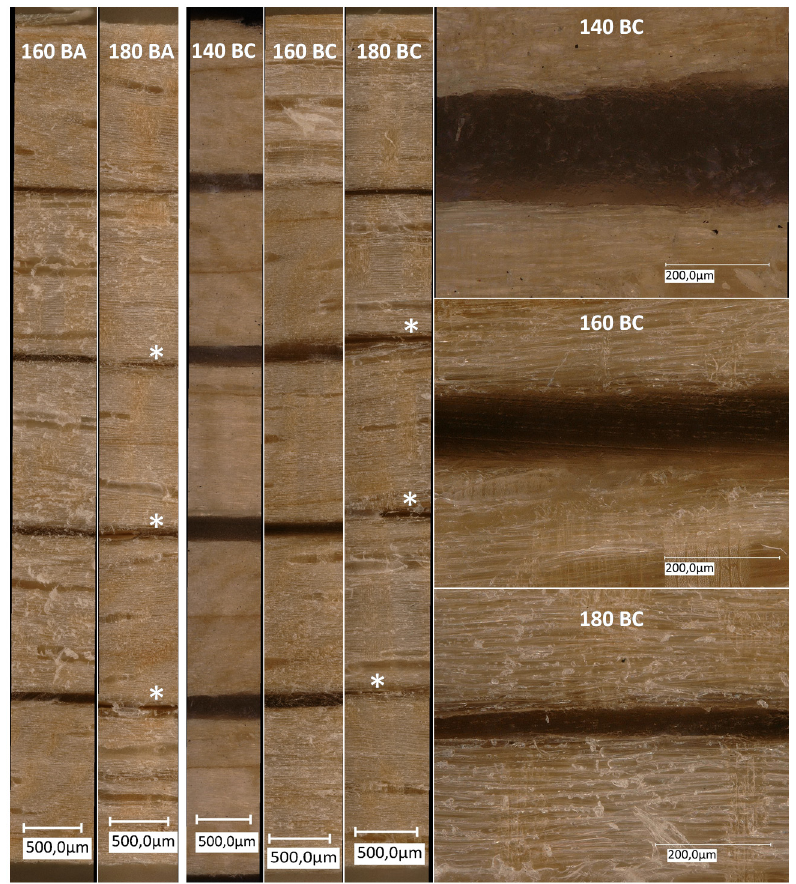
Figure 2. Comparison of birch laminated panel samples produced with amorphous (BA) and semi-crystalline (BC) PLA grades. Asterisks (*) indicate areas of unbonded veneer surfaces.